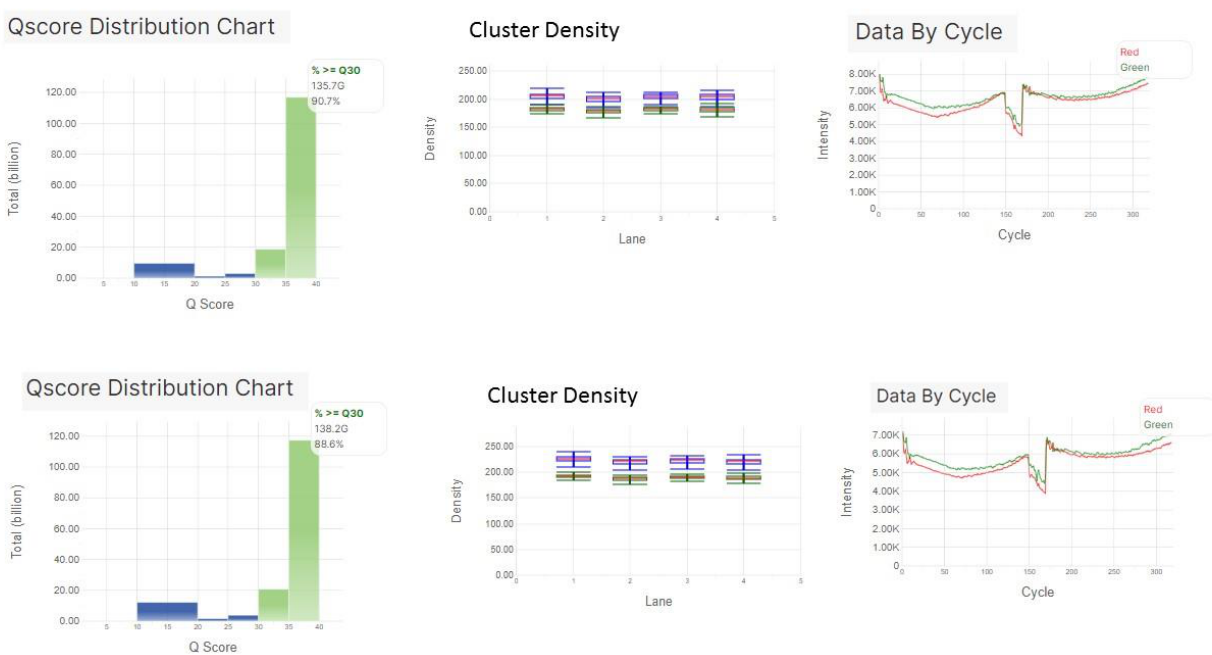
Figure 1. Sequencing performance of the viral sequencing panel performed on NextSeq550 platform. In Qscore distribution chart: blue bars represent raw clusters and the green bars represent clusters passing filter. In cluster density chart, each color line represents each lane.